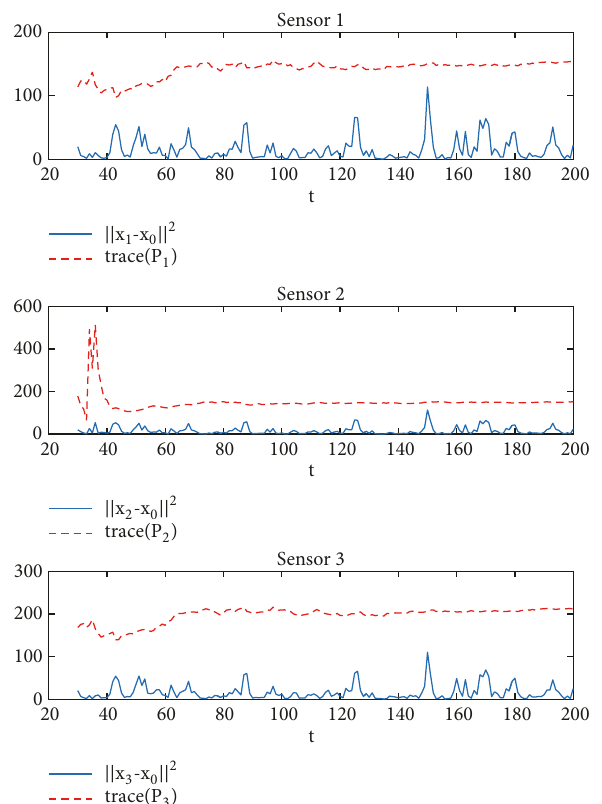
Figure 2: State estimation errors and covariances of sensors 1-3.